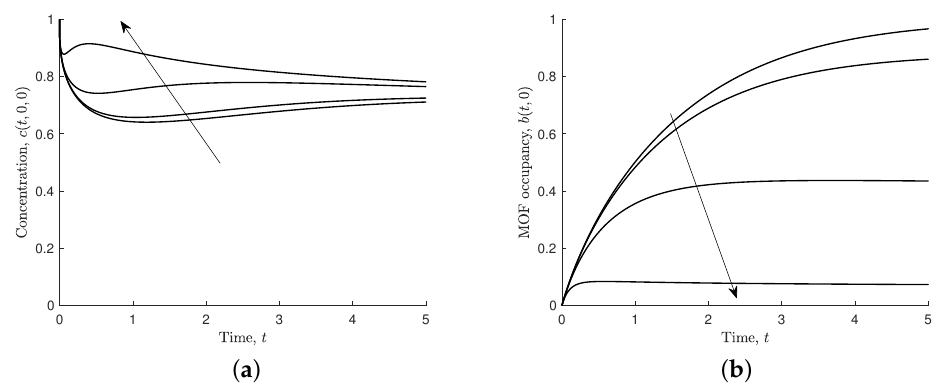
Figure A2. Results for different values of effective dissociation, s 3 = 0,0.1,1,10, s 1 = s 2 = s 4 = 1, and D = 0.5. Arrows indicate the direction of increasing s 3 . ( a ) Non-dimensional concentration of ferric ions through MOF-mid point across two media, c ( t ,0, x 2 ) . ( b ) Non-dimensional MOF occupancy, b ( t ,0 ) .